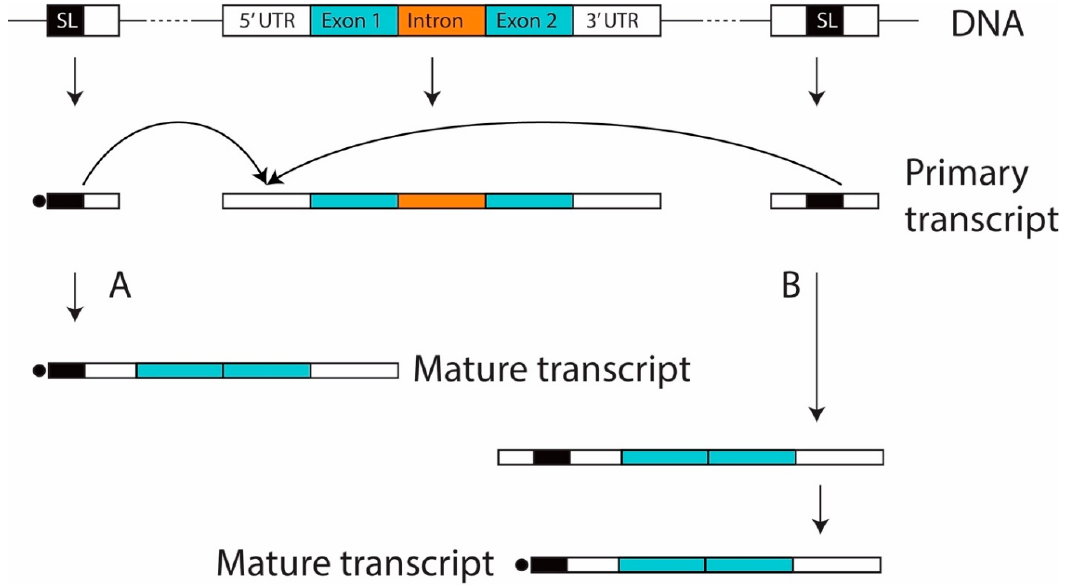
Figure 1. Spliced leader (SL) trans -splicing mechanism in dinoflagellates. ( A ) the mechanism previously thought; ( B ) a mechanism proposed based on the findings reported in this study, in which extra steps are needed to remove the sequences upstream from the SL before mRNA maturation.